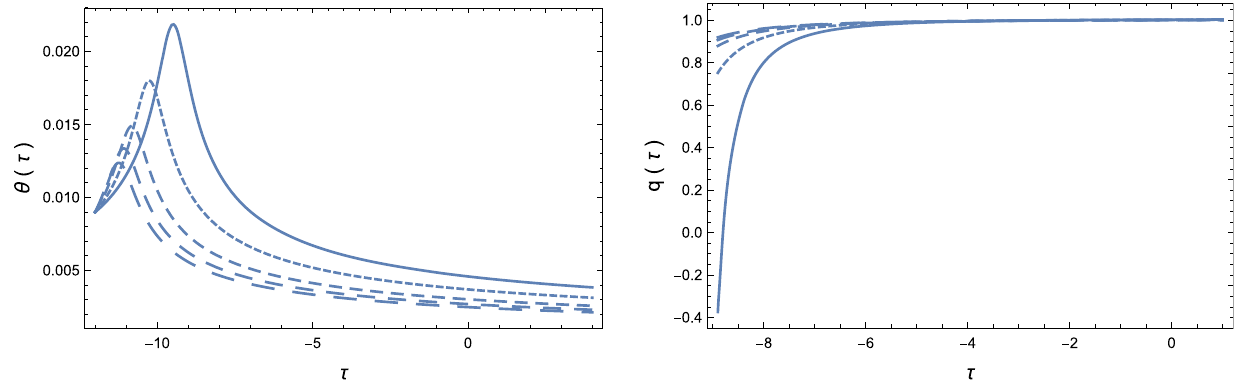
Fig. 3 Time evolution of the scale factor a (left figure) and of the dimensionless Hubble function h (right figure) in a loop quantum cos- mological Universe filled with a deformed photon gas with the disper- sionrelation E = kc ( 1 + λ E ) ,with λ k B T << 1,fordifferentvaluesof theparameter A 2 : A 2 = 10 7 (solidcurve), A 2 = 2 × 10 7 (dottedcurve),